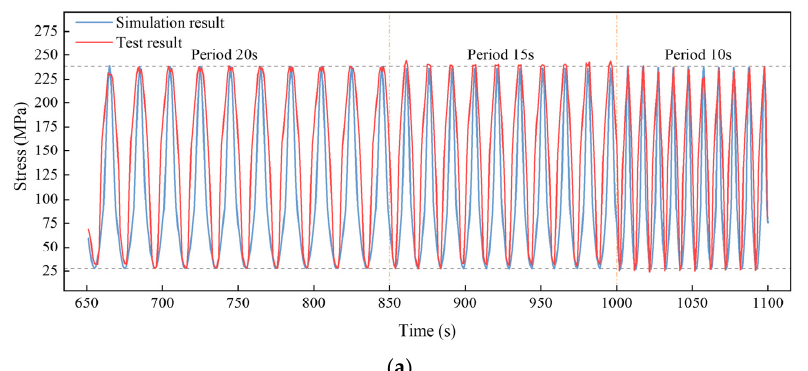
Figure 27. Time histories of the in-plane stress when the amplitude was 200 mm and the period decreased from 20 s to 10 s: ( a ) S2; ( b ) S5 and ( c ) S8.